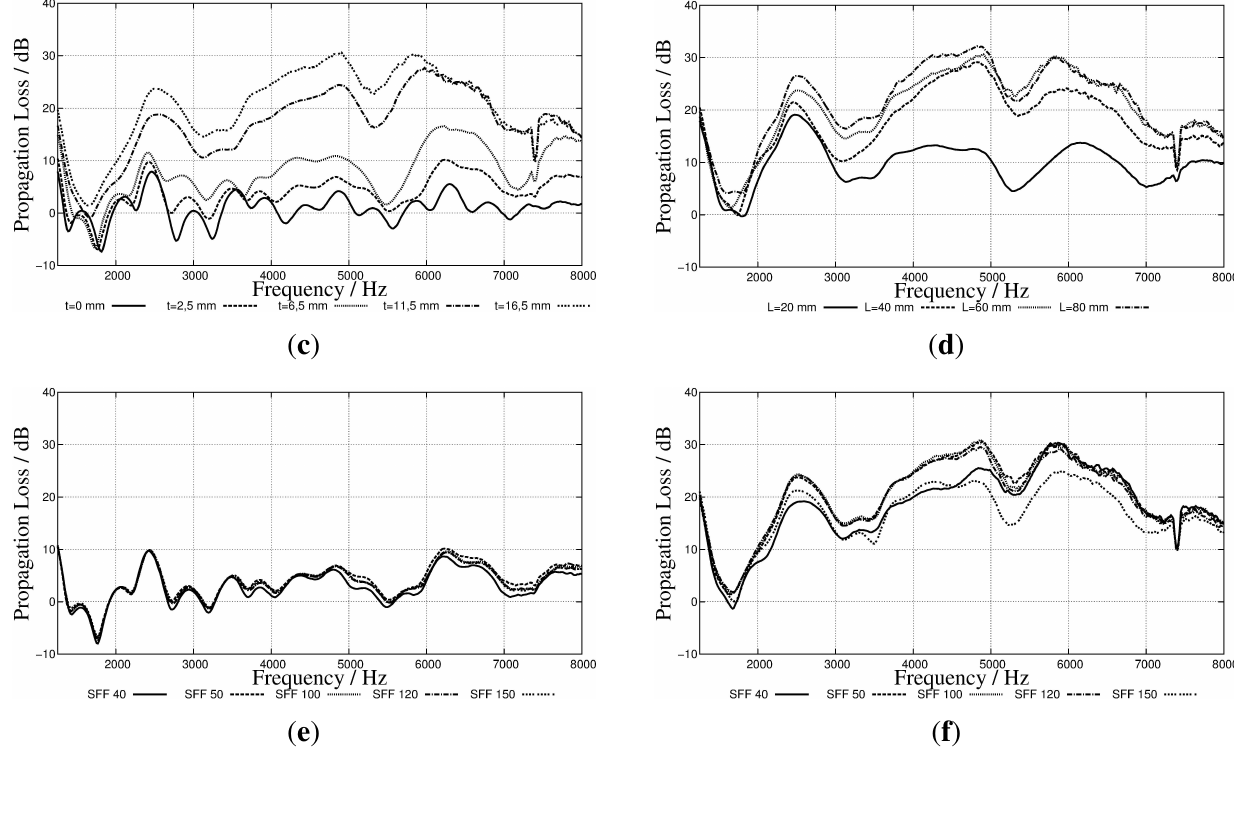
Figure 3. Experimental setup. ( a ) Impedance tube for transmission measurements; ( b )